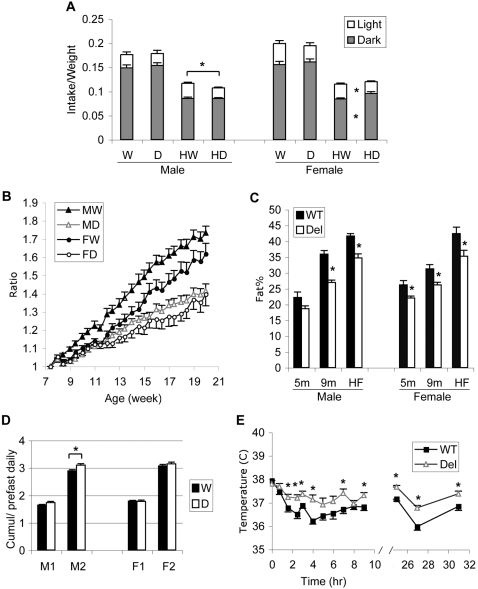
Feeding and energy homeostasis regulation of Snord116del mice and their WT littermates.A. Daily food intake and response to High-Fat (HF) diet. The intake of rodent chow during the dark (black bars) and light cycles (open bars) were measured for five consecutive days at 7 weeks of age. Then, the mice were placed on HF diet, and their intake was measured daily for five consecutive days. Food intake was normalized to average body weight during the five days of measurement. The daily intake on regular chow diet was not different between WT (W) and Snord116del (D) mice. On HF diet, the daily intake of the deletion males (HD) was significantly lower than that of their WT littermates (HW) (P<0.005). This was entirely due to decreased daytime intake. The deletion females on HF (HD) had lower intake in the dark (P<0.05), which was compensated by increased daytime intake (P<0.05), so that their total daily intake was not different from their WT littermates (HW). (Males, n = 16 WT, 16 Del; females n = 15 WT, 11 Del). B. Deletion mice gain less weight on HF diet. Eight-week old mice were put on HF for 4 months, and their body weight was measured twice per week and plotted as the ratio to their weight prior to HF diet. Differences between male WT (MW, n = 16) and male Snord116del (MD, n = 16) mice were significant at P<0.01 except for the first week on HF. Differences between female WT (FW, n = 15) and female deletion (FD, n = 11) mice were significant at P<0.05 after 7 weeks on HF. C. Deletion mice have less body fat on regular and HF diet. Dual energy X-ray absorptiometry was used to measure body composition of 5-months and 9-months old mice on rodent chow, and 6-months old mice that had been on HF diet for 4 months. The differences between WT and Snord116del mice are all significant, except for the 5-months old males on chow. Males, at 5 months (n = 13 WT, 9 Del; P = 0.07); at 9 months (n = 17, both genotypes, P<2 ×10−7); at 6 months after 4 months on HF diet (n = 16, P<0.0001). Females at 5 months (n = 12, both genotypes, P<0.02), at 9 months (n = 14 WT, 10 Del; P<0.007) and at 6 months after 4 months on HF diet (n = 15 WT, 10 Del; P<0.02). D. Compensatory food intake after fasting. Mice at 3 months of age were fasted for 24 hr, and the ratio of their cumulative food intake to their average pre-fasting daily intake was computed. M1 and M2, cumulative intake ratios of males in the first 24 and 48 hr (n = 13 WT, 9 Del). F1 and F2, cumulative intake ratios of females in the first 24 and 48 hr (n = 12). The deletion mice were able to compensate within 48 hr for the missed feeding. The deletion males over-compensated compared to their WT littermates (P<0.02). E. Maintenance of body temperature in cold environment. The core body temperature of 4 months old Snord116del (n = 9) and WT (n = 13) males in a 4°C cold room was measured with an anal probe. The mutants were better able to maintain their core temperatures over extended time. Asterisks indicate P<0.05.